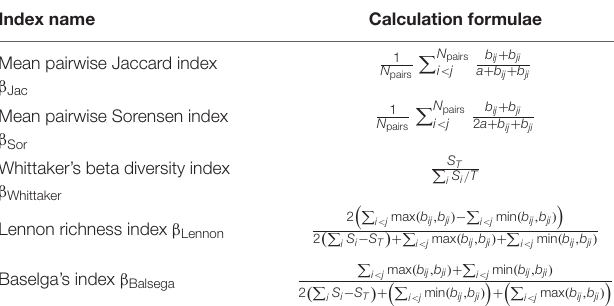
TABLE 1 | Multi-site beta diversity indices used in the present